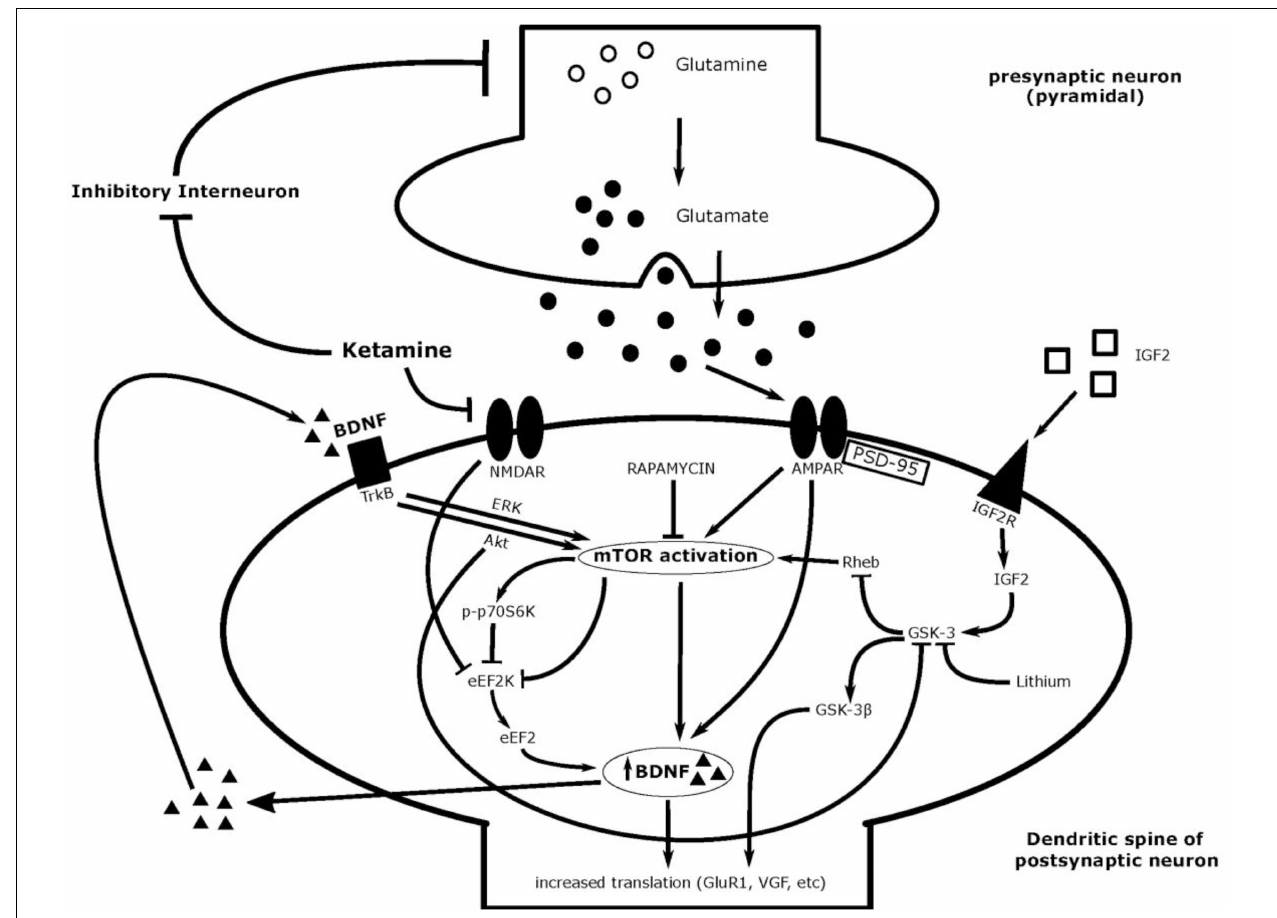
FIGURE 2 | Ketamine’s postulated mechanism of action and associated molecules.